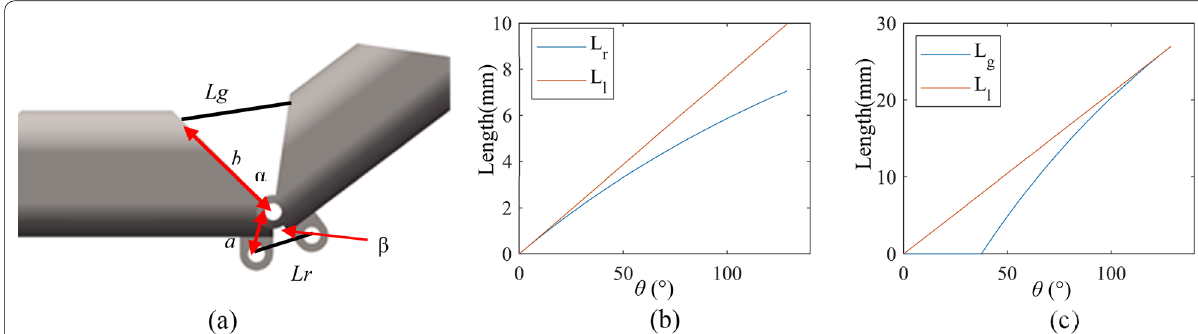
Figure 2 ( a ) Finger joint in the grasp process, ( b ) Length change of L l and L r during flexion, ( c ) Length change of L l and Lg during